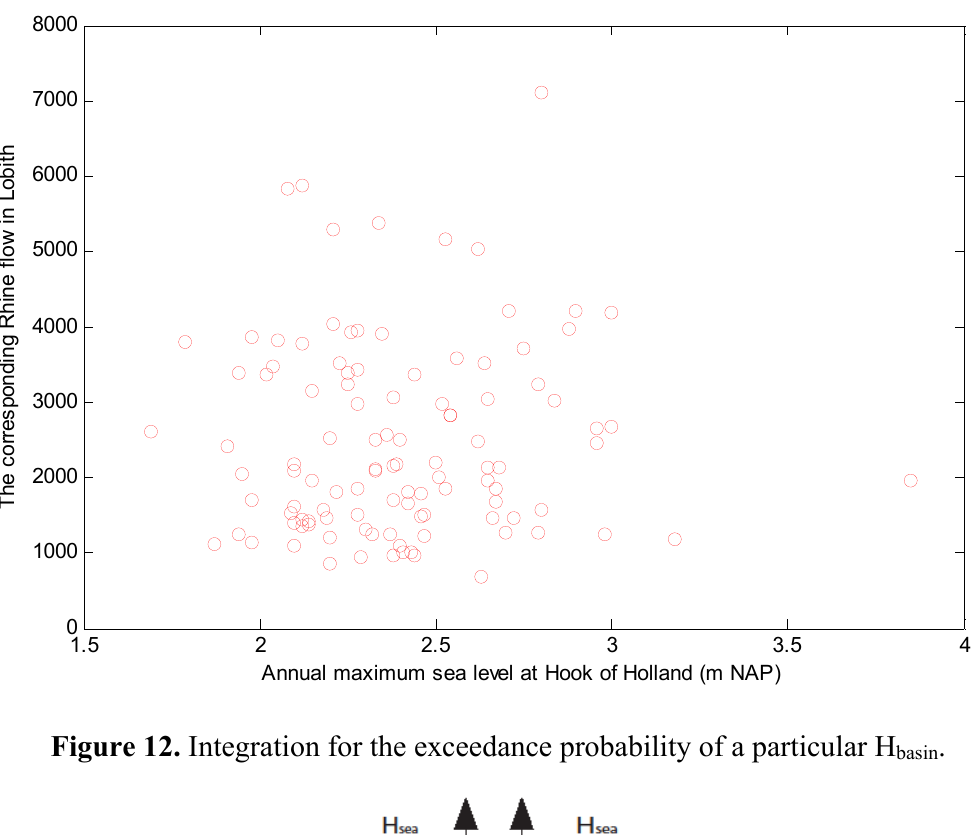
Figure 11. Annual maximum sea levels against corresponding Rhine flows.